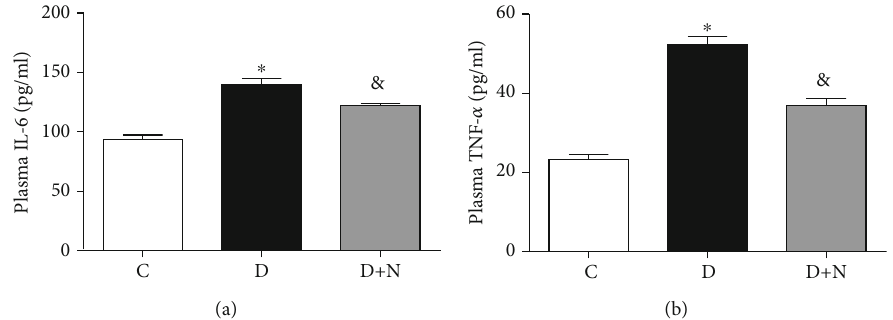
Figure 6: E ff ect of three weeks of NAC treatment on change in plasma IL-6 and TNF- α level of diabetic rats measured by ELISA analysis. All results are presented as means ± SD , n = 6 /group; ∗ P < 0 : 05 (D vs. C), & P < 0 : 05 (D+N vs.